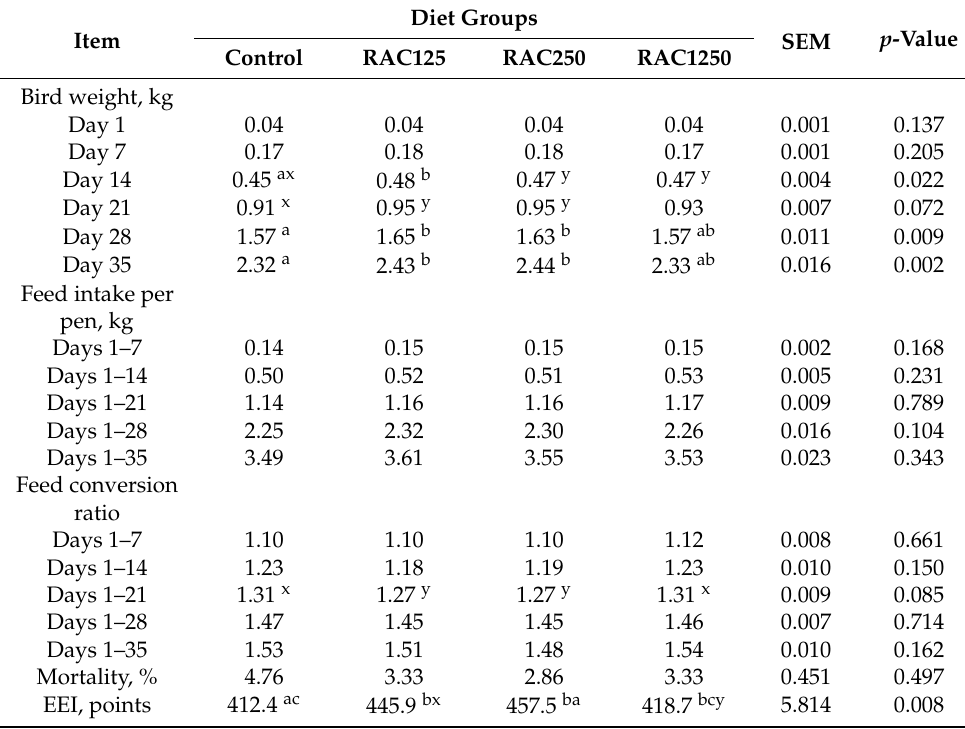
Table 4. Production performance of broilers in trial 1.